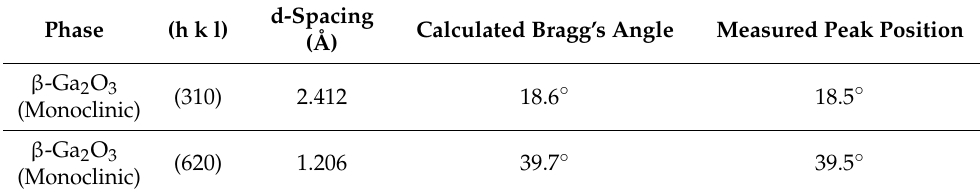
Table 3. Summary of measured and calculated reflection angle from the annealed Ga 2 O 3 grown on c-plane sapphire substrate (lattice parameter of monoclinic β -Ga 2 O 3 : a = 12.23 Å, b = 3.04 Å, c = 5.8 Å, and β = 103.7°).